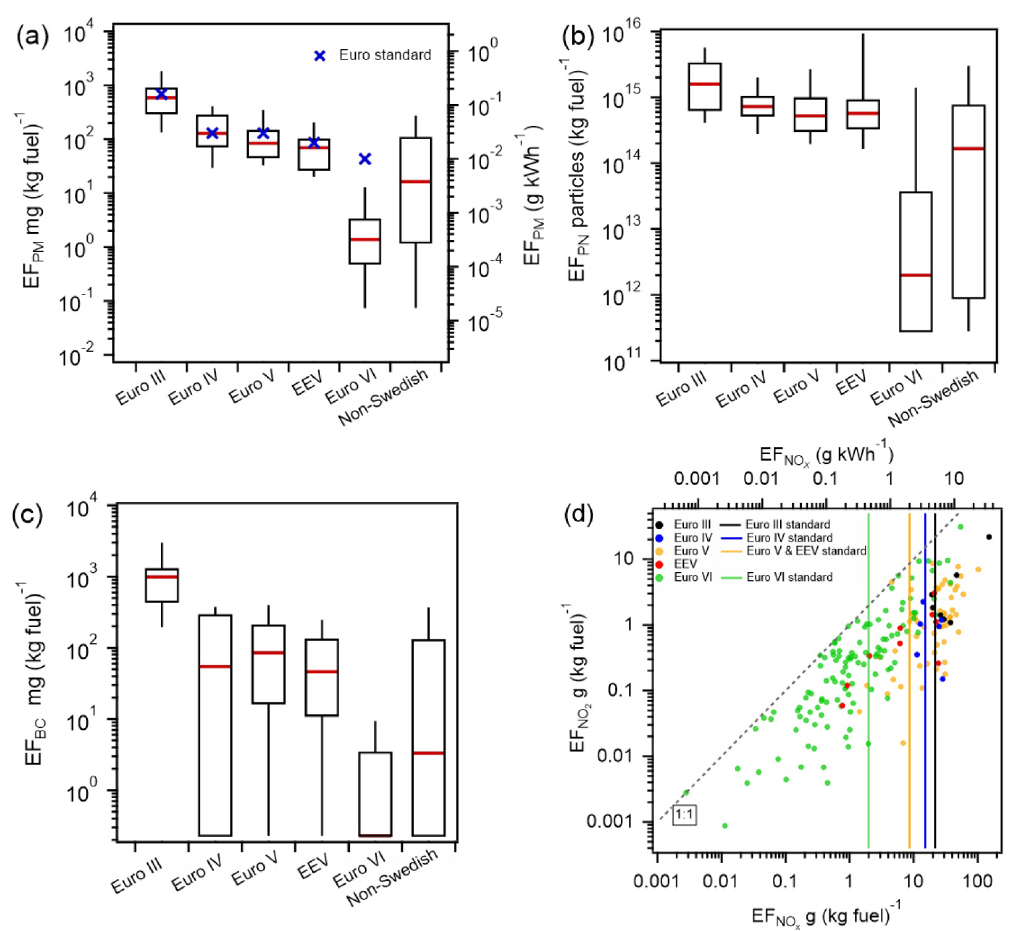
Figure 2. (a) EF PM , (b) EF PN , (c) EF BC , (d) EF NO and EF NO for Euro III to Euro VI and non-Swedish HDTs. Non-detectable pollutant x 2 emission signals for captured plumes have been replaced by EF min . For box-and-whisker plots, the top and the bottom line of the box are 75th and 25th percentiles of the data, the red line inside the box is the median, and the top and bottom whiskers are 90th and 10th percentiles. Note that the median EF BC of Euro VI HDTs overlaps with the bottom of the box. EF NO values in (d) are in NO 2 equivalents. HDTs x with either EF NO or EF NO lower than the detection limits of the instruments were removed in (d) for illustration purposes. Note that the x 2 comparison with the emission standard is only indicative as they are based on test cycle